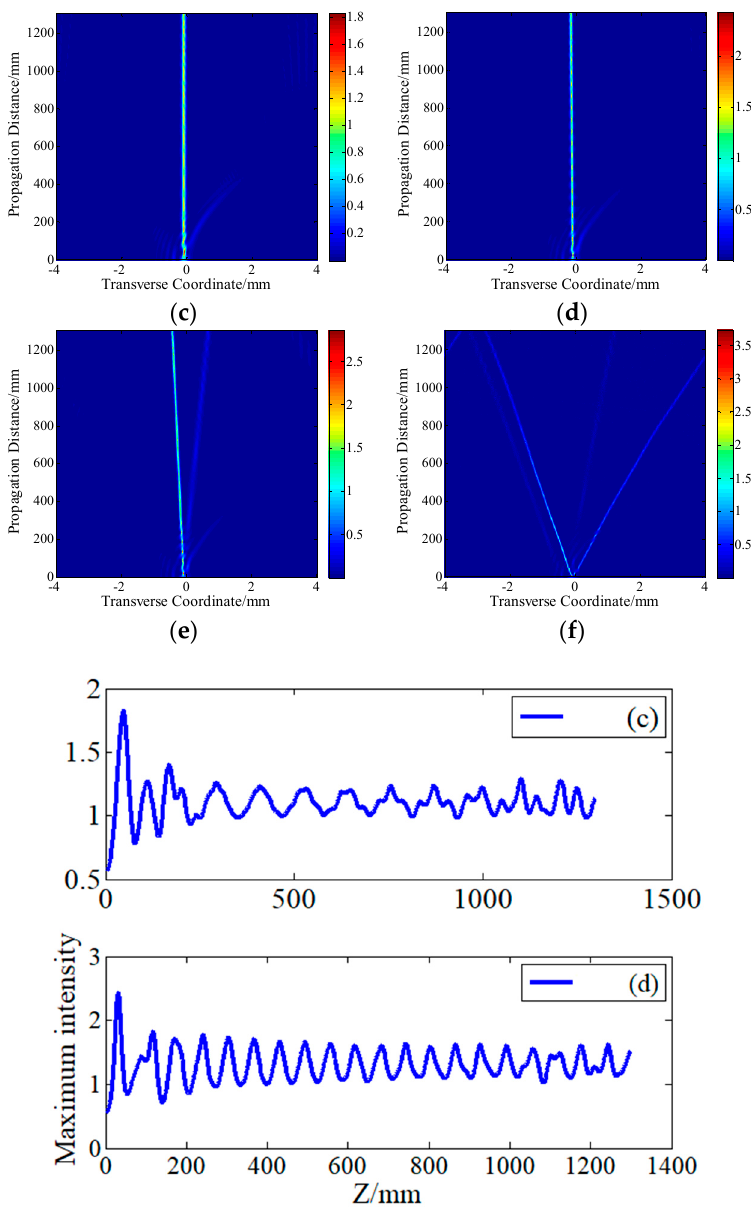
Figure 2. The propagation property of a 1D Airy beam in Kerr media with different third-order refractive indexes: ( a ) 𝑛 (cid:2870) = 5 × 10 (cid:2879)(cid:2874) m (cid:2870) W (cid:2879)(cid:2869) ; ( b ) 𝑛 (cid:2870) = 1.5 × 10 (cid:2879)(cid:2873) m (cid:2870) W (cid:2879)(cid:2869) ; ( c ) 𝑛 (cid:2870) = 3.5 × 10 (cid:2879)(cid:2873) m (cid:2870) W (cid:2879)(cid:2869) ; ( d ) 5.5 × 10 (cid:2879)(cid:2873) m (cid:2870) W (cid:2879)(cid:2869) ; ( e ) 7.5 × 10 (cid:2879)(cid:2873) m (cid:2870) W (cid:2879)(cid:2869) ; ( f ) 15 × 10 (cid:2879)(cid:2873) m (cid:2870) W (cid:2879)(cid:2869) ; and ( g ) is the maximum intensities of the beam in ( c , d ) versus propagation distance.